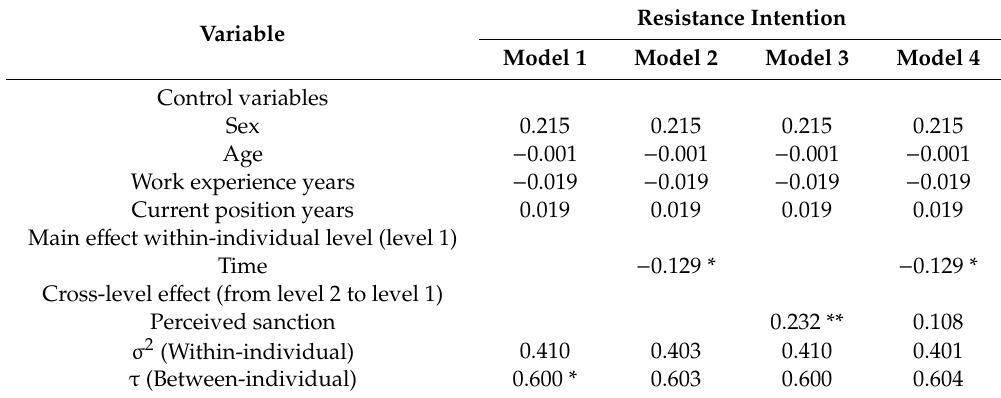
Table 4. Hierarchical linear models predicting the decrease of resistance intention from T1 to